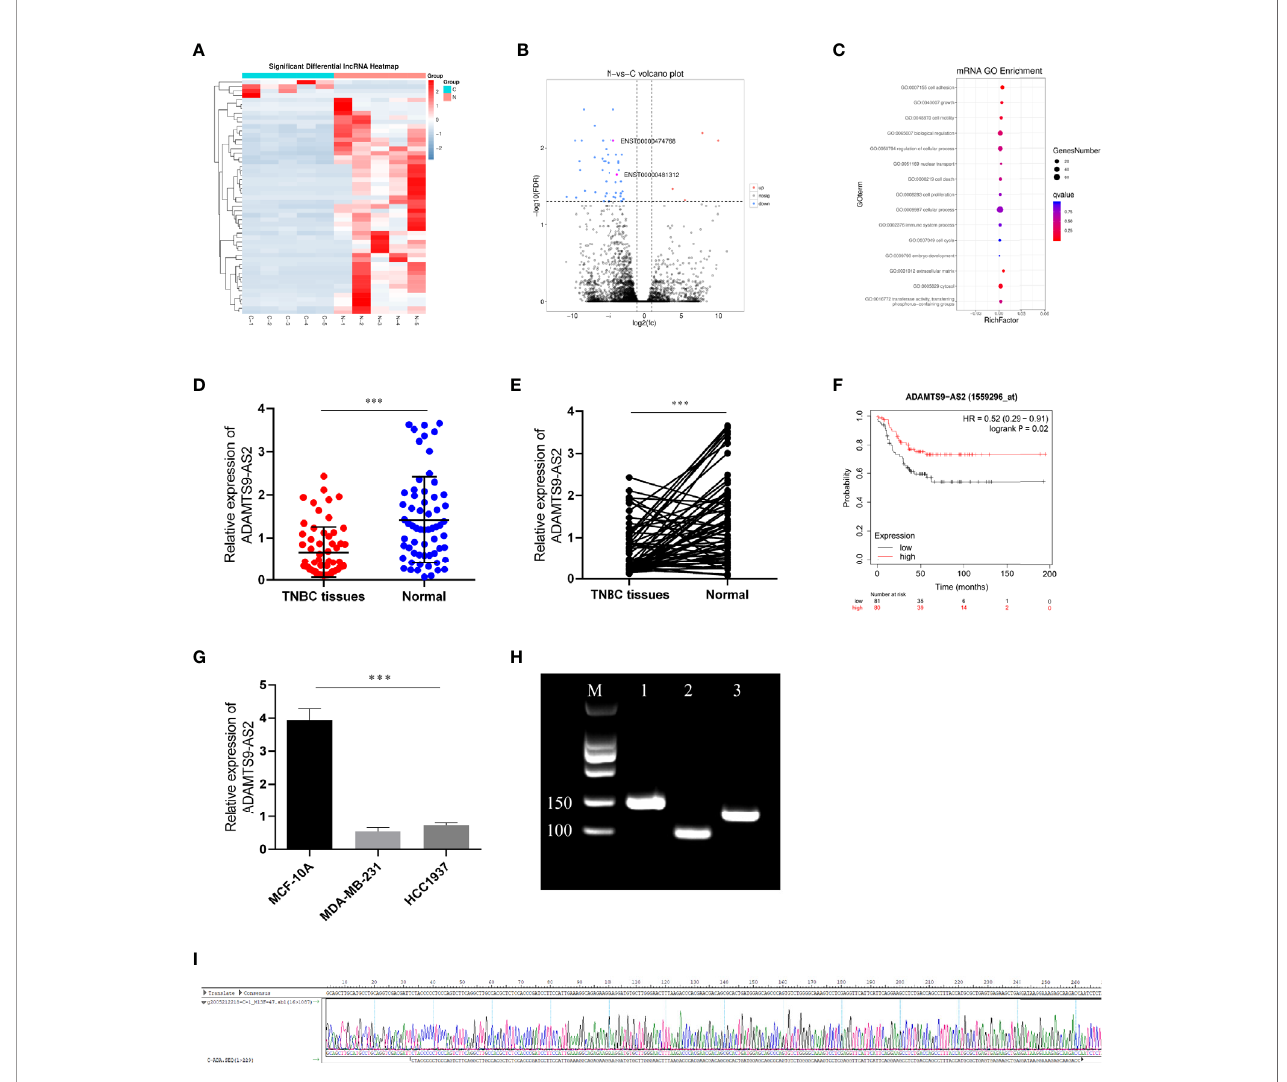
FIGURE 1 | ADAMTS9 ‐ AS2 is downregulated and associated with poor prognosis in TNBC patients. (A, B) The cluster heat maps and the volcano plot visualize the expression of lncRNA between TNBC tissues and adjacent non-tumor tissues. The red dots and green dots represent upregulated and downregulated LncRNAs with statistical signi fi cance, respectively. (C) GO pathway analysis of TNBC tissues. (D, E) Relative expression of ADAMTS9 ‐ AS2 in 62 TNBC tissues and adjacent normal tissues. (F) Kaplan – Meier survival curve of patients with TNBC downloaded from TCGA database. (G) Relative expression of ADAMTS9 ‐ AS2 in TNBC cell lines and normal breast cell line. (H, I) PCR product in agarose gel electrophoresis and the splicing site veri fi ed by DNA sequencing. ***P < ( Figure 3J ). As such, ADAMTS9-AS2 may suppress TNBC progression in vitro.